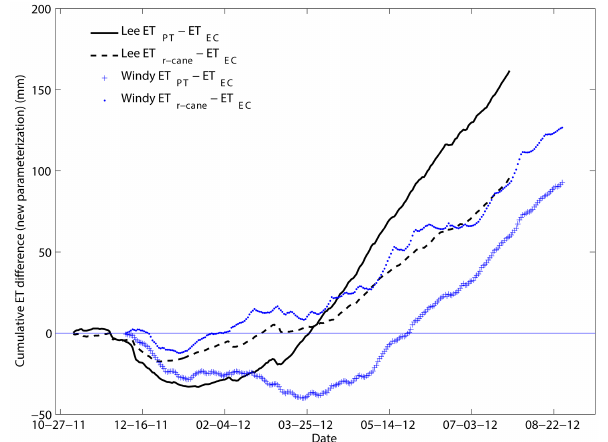
Figure 11. Cumulative difference between new reference ET (cus- tom bulk canopy resistance of 165sm − 1 ) and measured ET for both EC tower fields during the